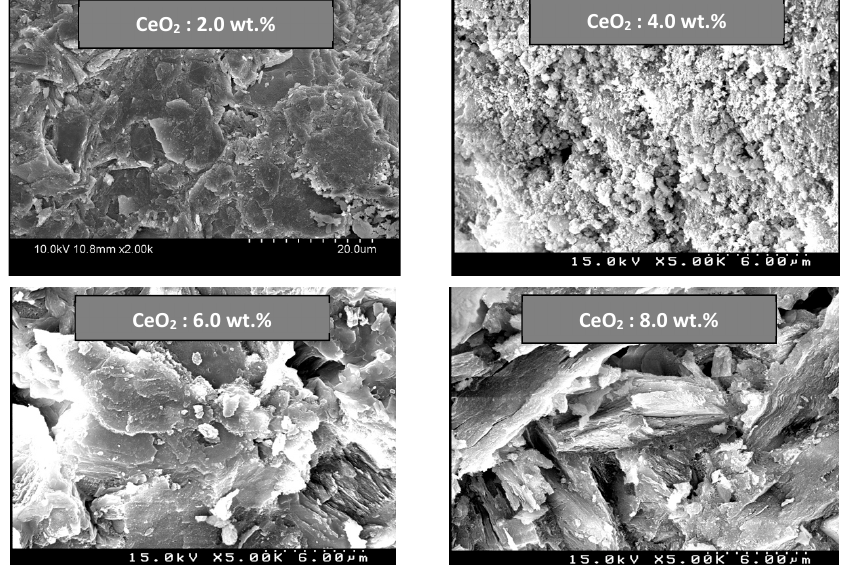
Figure 8. SEM images of Ni-based catalysts impregnated with various CeO 2 content after auto-thermal reforming of toluene at 800 ◦